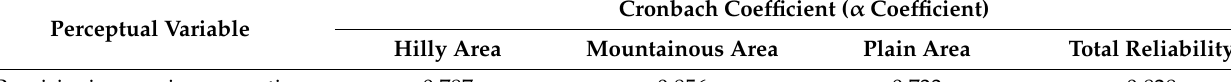
Table A5. Culture service perception indicators, options, and values. Statistical Results of Question- naire Data Reliability.